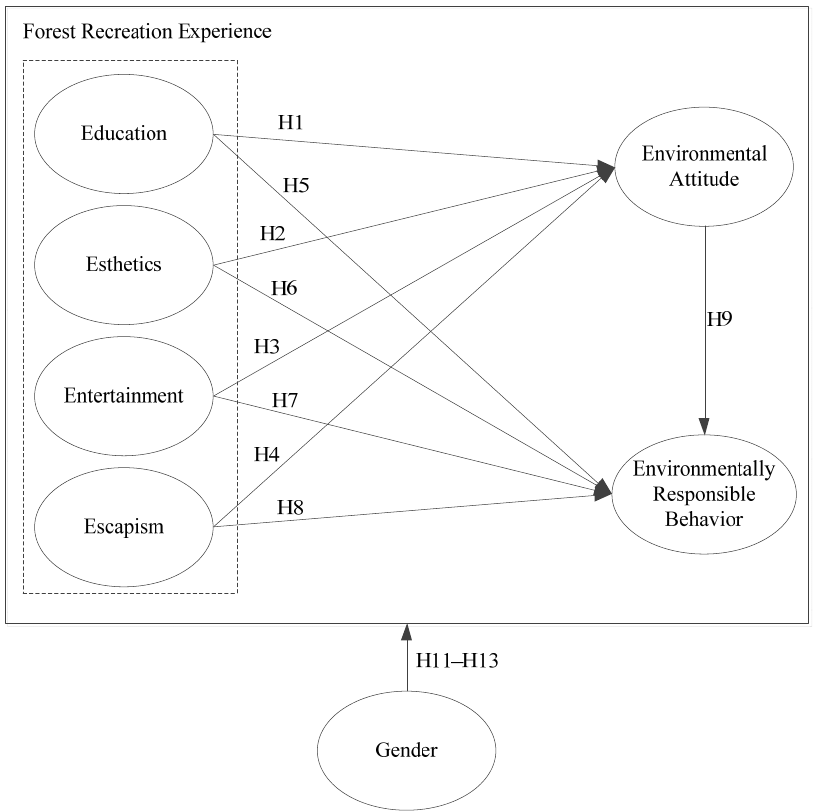
Figure 1. The conceptual framework.